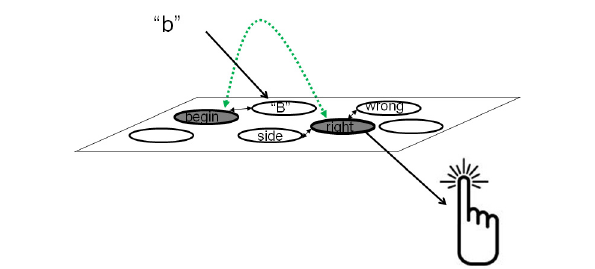
FIGURE 2 | An example for a representation of a simple rule such as IF (the stimulus is a letter from the beginning of the alphabet) THEN (press the right key). When the instructions are given, the long-term memory representations of “letter,” “beginning of the alphabet” and “right” are activated. The novel binding between “beginning of the alphabet” and “right” (presented in green color) is in the region of direct-access. When a letter such as “b” is presented, it activates its corresponding representation in long-term memory. Via links in long-term memory, the representation of “beginning of the alphabet” is also further activated, leading to the activation of “right” (via the novel link) and to the key press (via established links in long-term